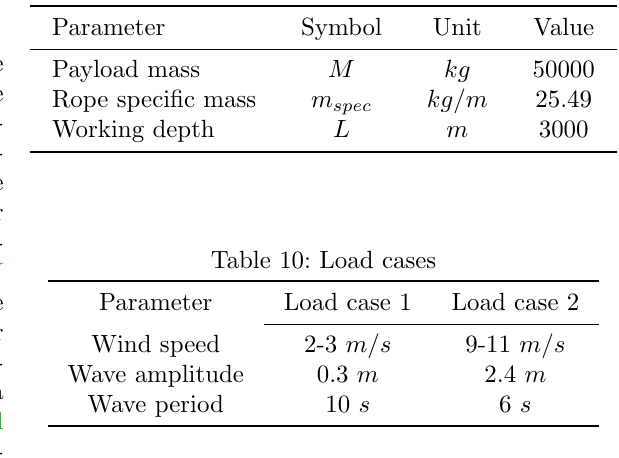
Table 9: Carried load and working depth